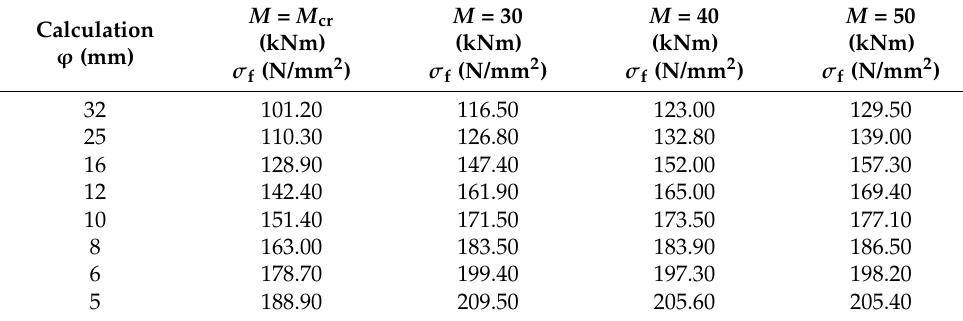
Table 5. Results of parametric